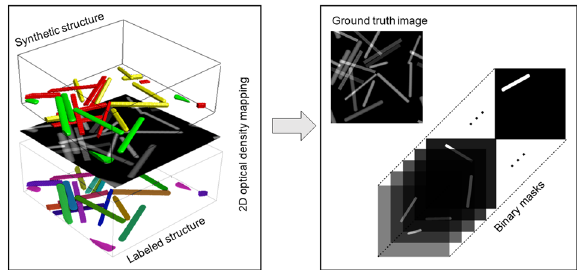
Fig. 2 Synthetically generated dataset for training procedure. The 3D microstructure is compressed to create optical density-based image as input data. The individually labeled nanowires in correlation with the optical density-based image are then used to create the binary masks for output